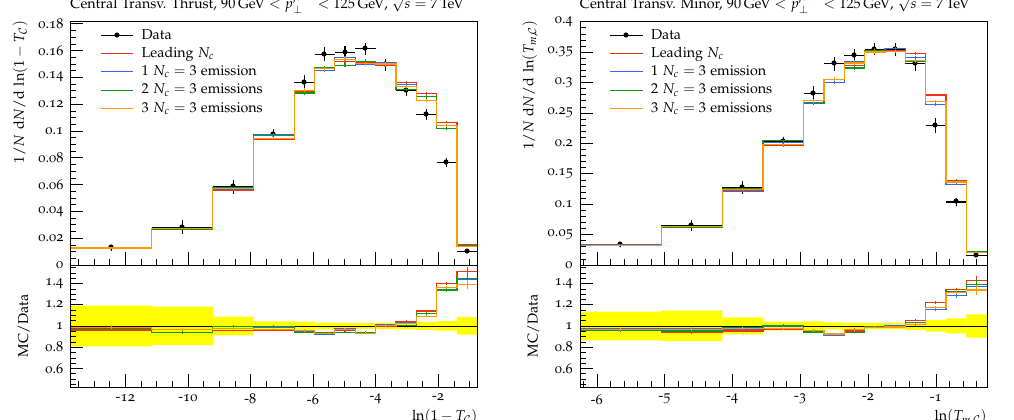
Figure 8 . Distribution of log analysis are taken from